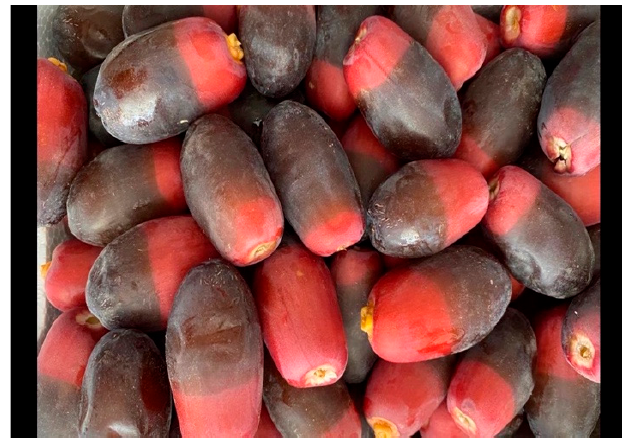
Figure 4. Sample of Al-helwa dates.